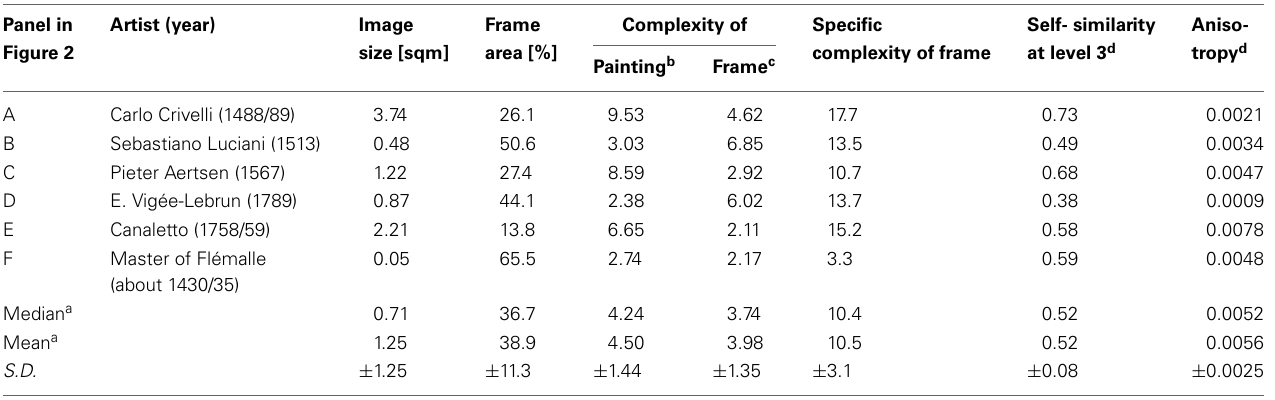
Table 1 | Results for the paintings with frames (PwF images) shown in Figure 2. Panel in